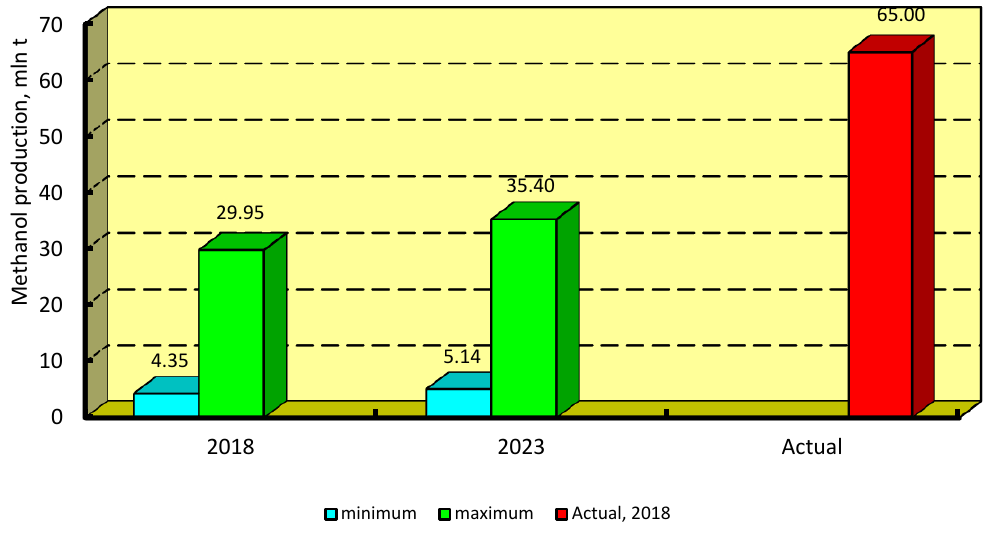
Figure 17. Potential production of MSW -based methanol.